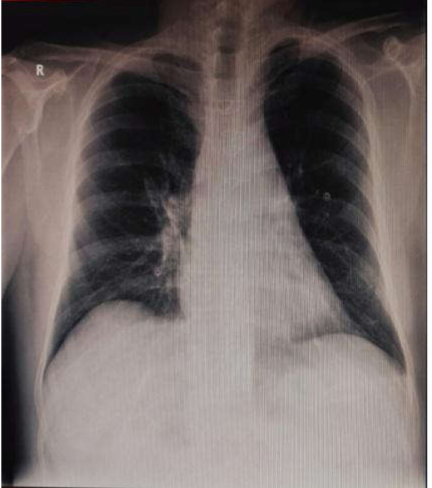
Figure 7. Postoperative chest X-ray.